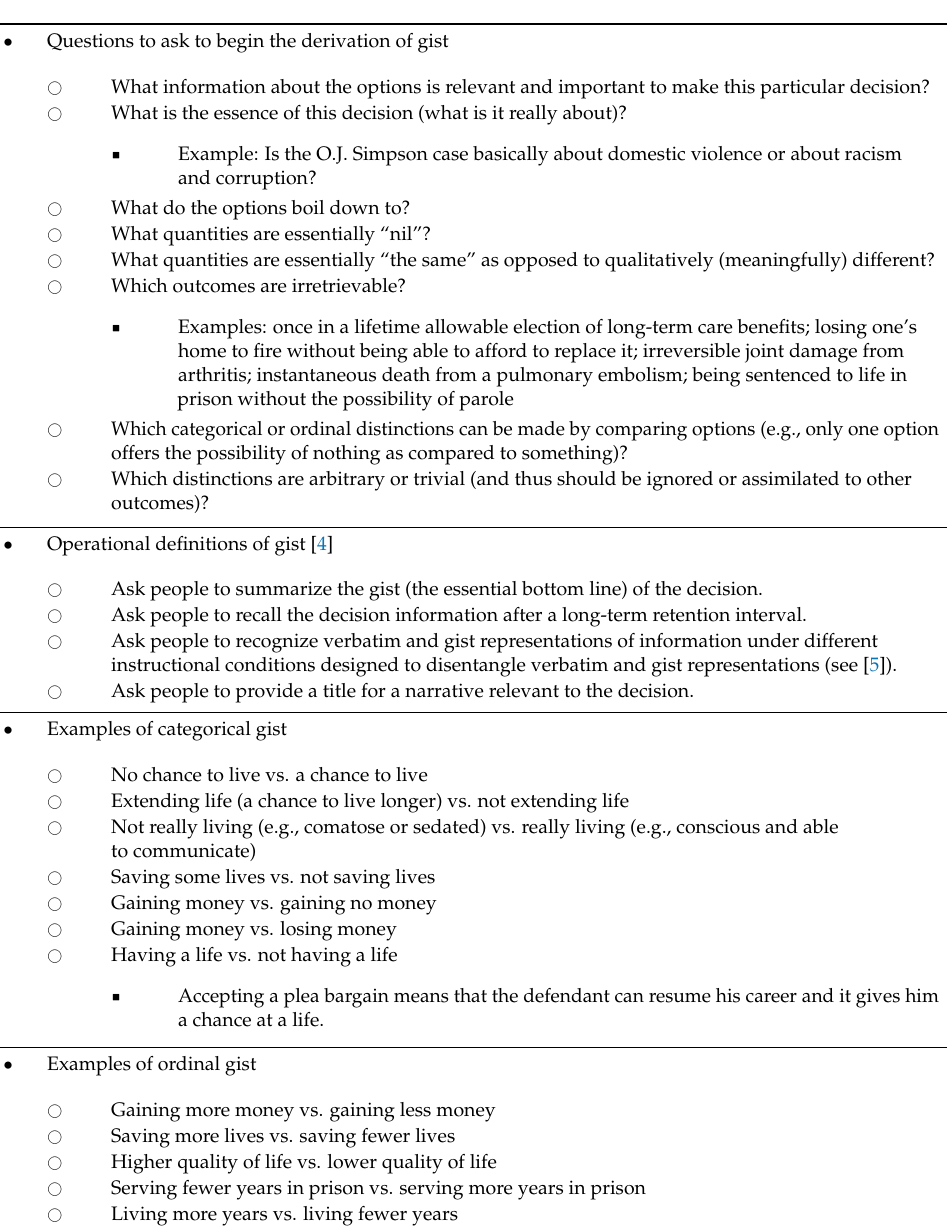
Table 1. Determining Potential Gist Representations that are Likely to be Encoded for a Particular Decision or